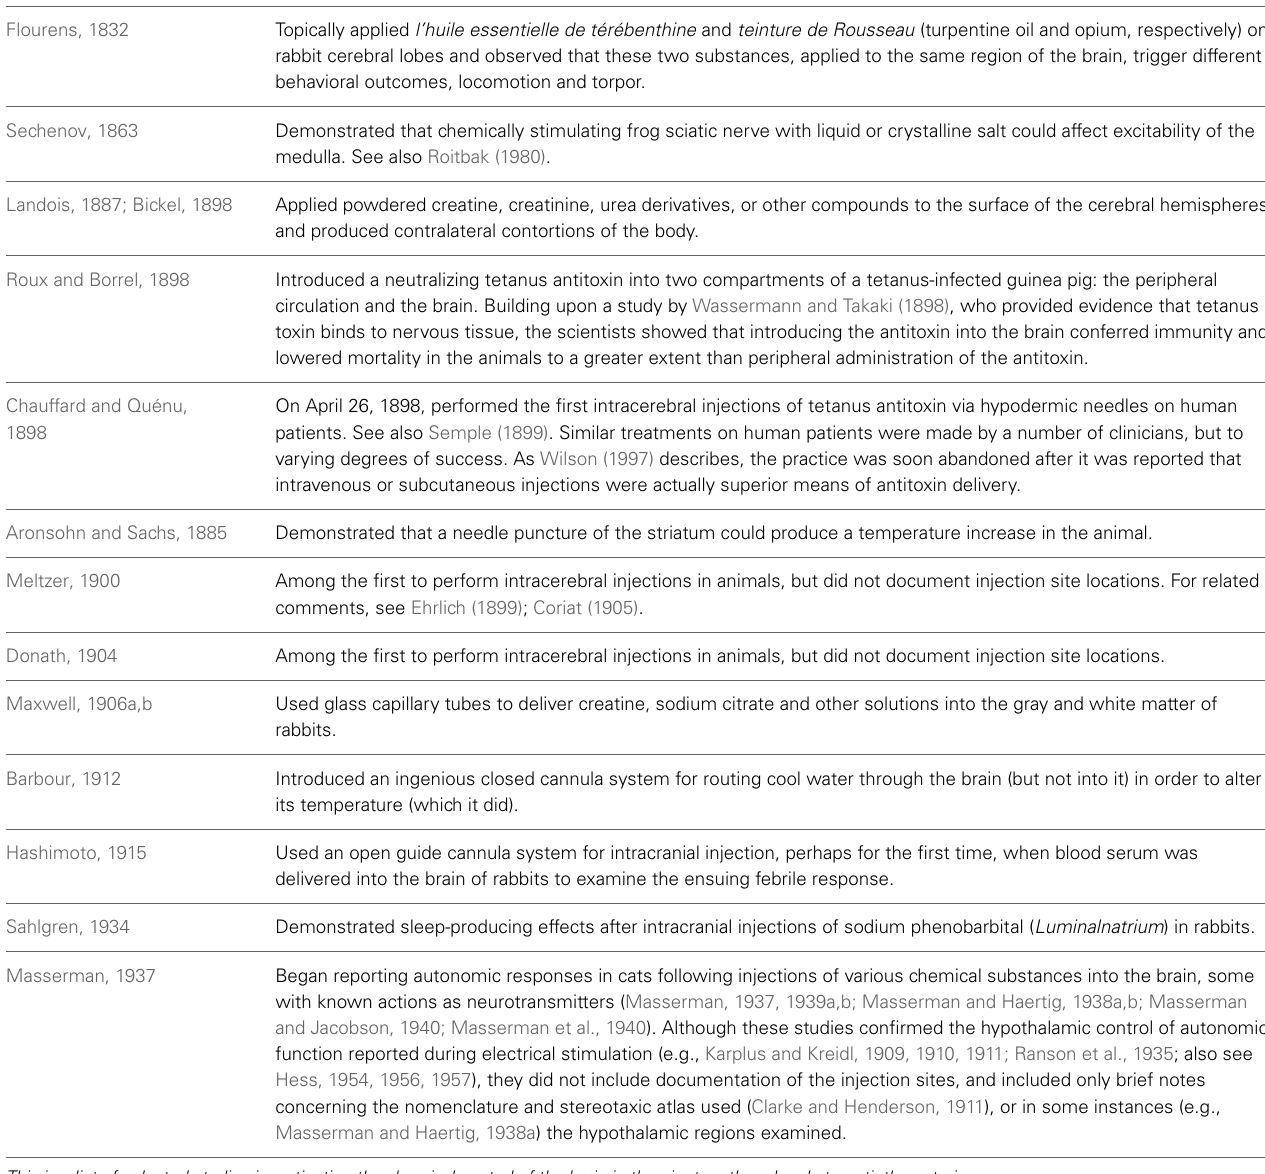
Table 1 | Early studies investigating the chemical control of the